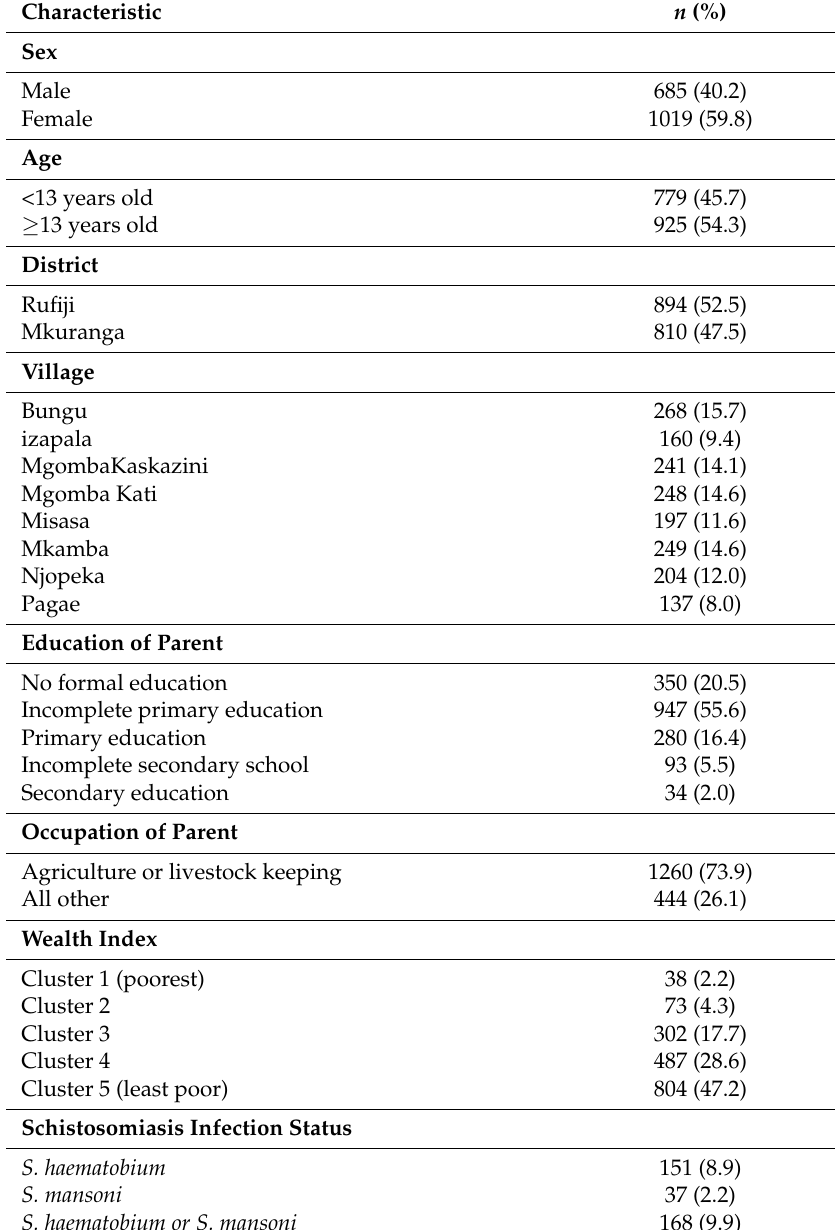
Table 5. General characteristics of Tanzanian schoolchildren who participated in this study ( n = 1704).